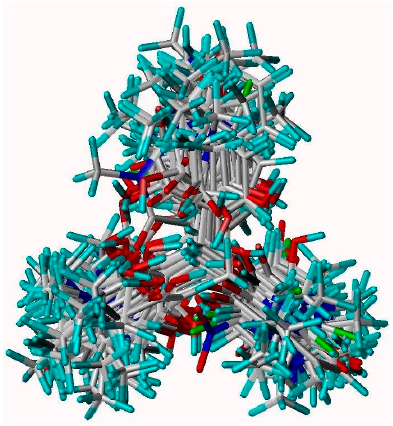
Figure 1. Superimposed view of 1 – 44 compounds by structure-based alignment using the reference ligand of 1E9Y.pdb. Cyan, red, blue, green and white color represent Hydrogen, Oxygen, Nitrogen, Chlorine and Carbon atom, respectively.